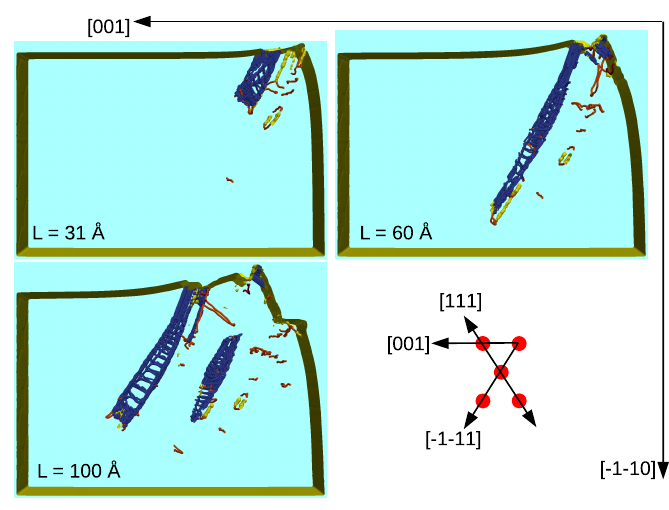
Figure 3. As in Figure 2, but for a rake angle of − 22.5 ◦ and various cutting lengths L .